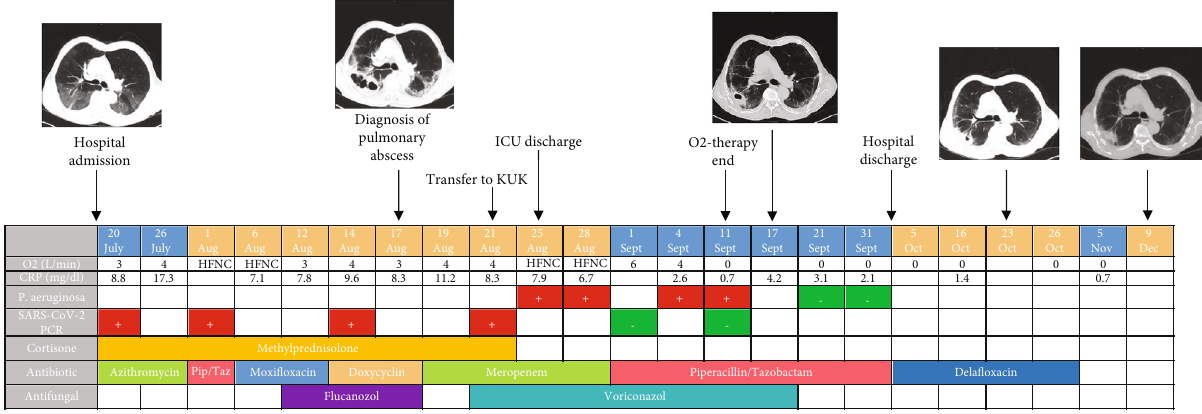
Figure 2: Timeline showing the key parameters and therapies. KUK=Kepler University Hospital; ICU=intensive care unit; Aug =August; Sept=September; Oct=October; Nov =November; Dec=December; HFNC=high- fl ow nasal cannula oxygen; CRP=C-reactive protein; SARS-CoV-2=severe acute respiratory syndrome coronavirus type 2; PCR=polymerase chain reaction; Pip/Taz